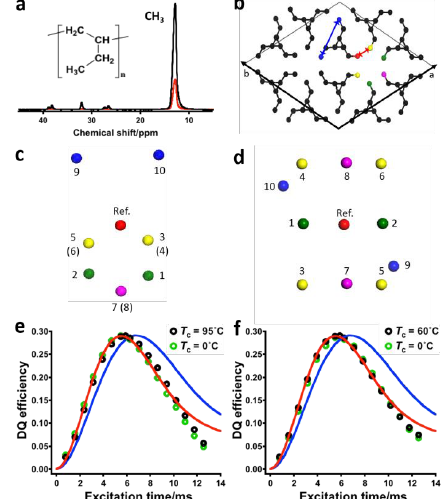
Figure 1. ( a ) 13 C relaxation-filtered single quantum (SQ) (black) and double quantum (DQ) (red) cross-polarization magic angle spinning (CPMAS) NMR spectra of 35 wt% 13 CH 3 -enriched i PB1 form I-rich sample grown at T c = 95 ◦ C. ( b ) Trigonal crystal structure of i PB1 form I determined by wide angle X-ray diffraction (WAXD) and corresponding 11-spin system of 13 C CH 3 groups on the (001) plane [67]. The projection of the 11-spin systems on the ( c ) (001) and ( d ) (120) planes. The DQ buildup curves of i PB1 form I ( e ) melt grown-crystals crystallized at 95 ◦ C (black open circles) and at ~0 ◦ C (green ones) and ( f ) solution-grown crystals at 60 ◦ C (black ones) and at ~0 ◦ C (green ones). In ( e ) and ( f ), the simulated red and blue DQ curves based on the closest interstem 13 C– 13 C internuclear distance; < r > of 4.0 Å; and an exponential T 2 of 8.3 ms and < r > = 4.2 Å and T 2 = 10.5 ms, respectively. (Reprinted with permission